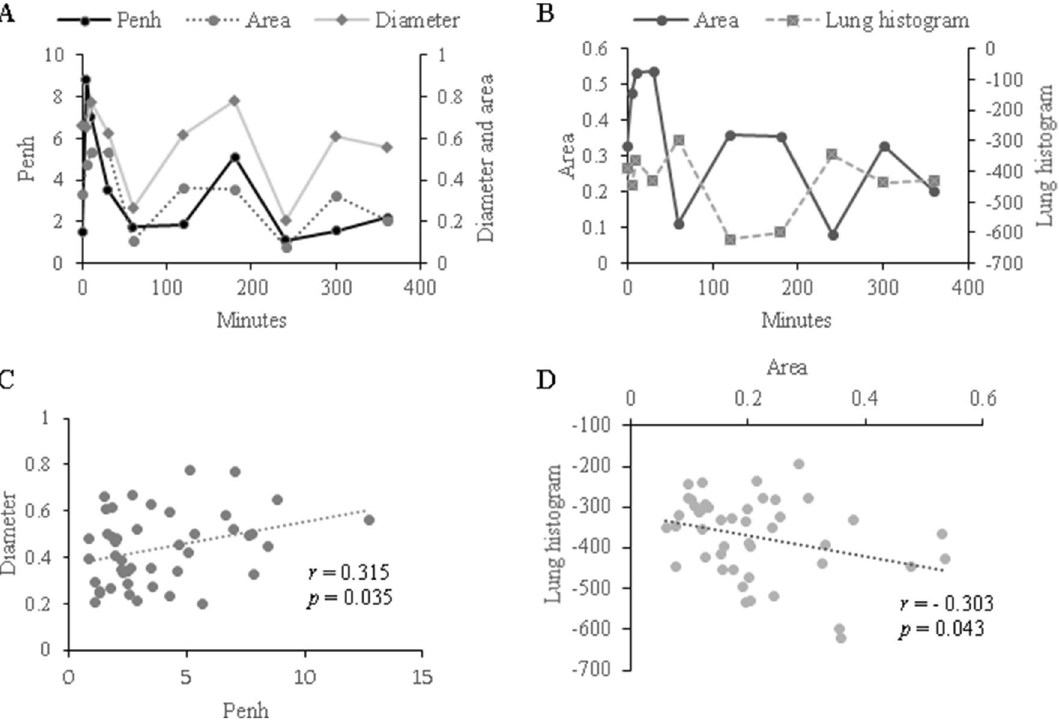
Figure 6. Correlation between imaging parameters. (A) In mouse 1, serial changes of Penh, bronchial diameter and bronchial area up to 10 h after OVA challenge. (B) Correlation between Penh and bronchial diameter. (C) In mouse 1, serial changes of bronchial area and lung histogram after OVA challenge. (D) Correlation between bronchial area and lung histogram. Penh was well correlated with diameter and area. Reduced airflow is correlated with wider bronchial diameter. Bronchial area was negatively correlated with lung histogram. These changes in proximal airway are also closely correlated with air trapping in